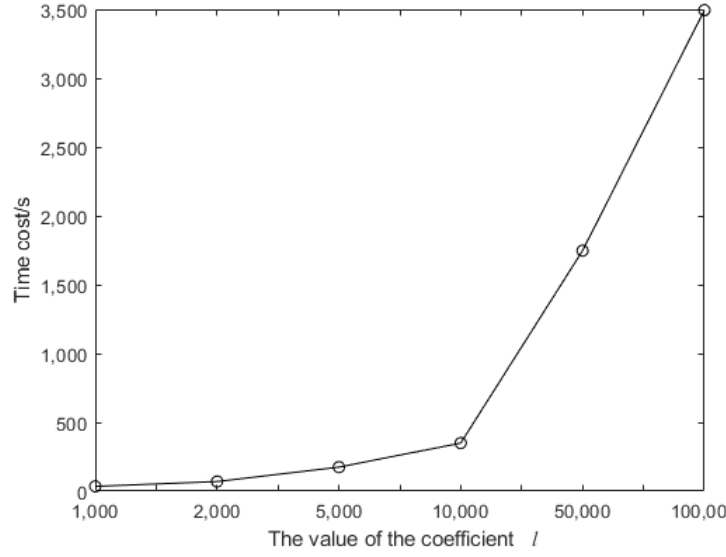
Figure 4. Service time based on different values of l .